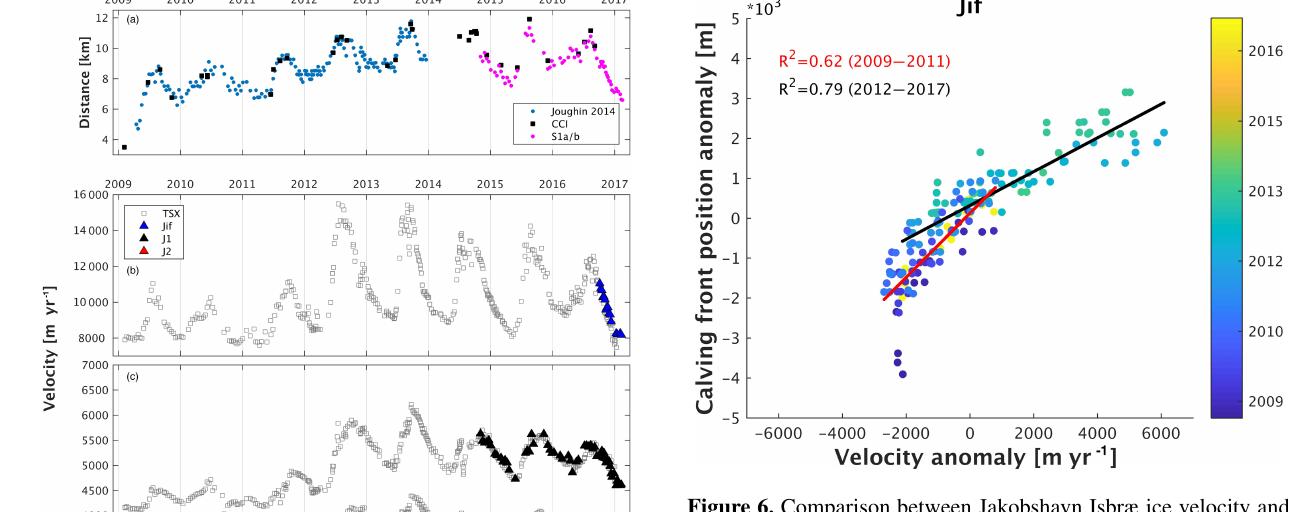
Figure 6. Comparison between Jakobshavn Isbræ ice velocity and calving front position anomalies at the Jif site, 0.8km upstream of the calving front, between 2009 and early 2017. Positive values cor- respond to ice front retreat and speedup respectively. The red and black lines represent the linear regression through the 2009–2011 and 2012–2017 periods, respectively, together with the correlation coefficients ( R 2